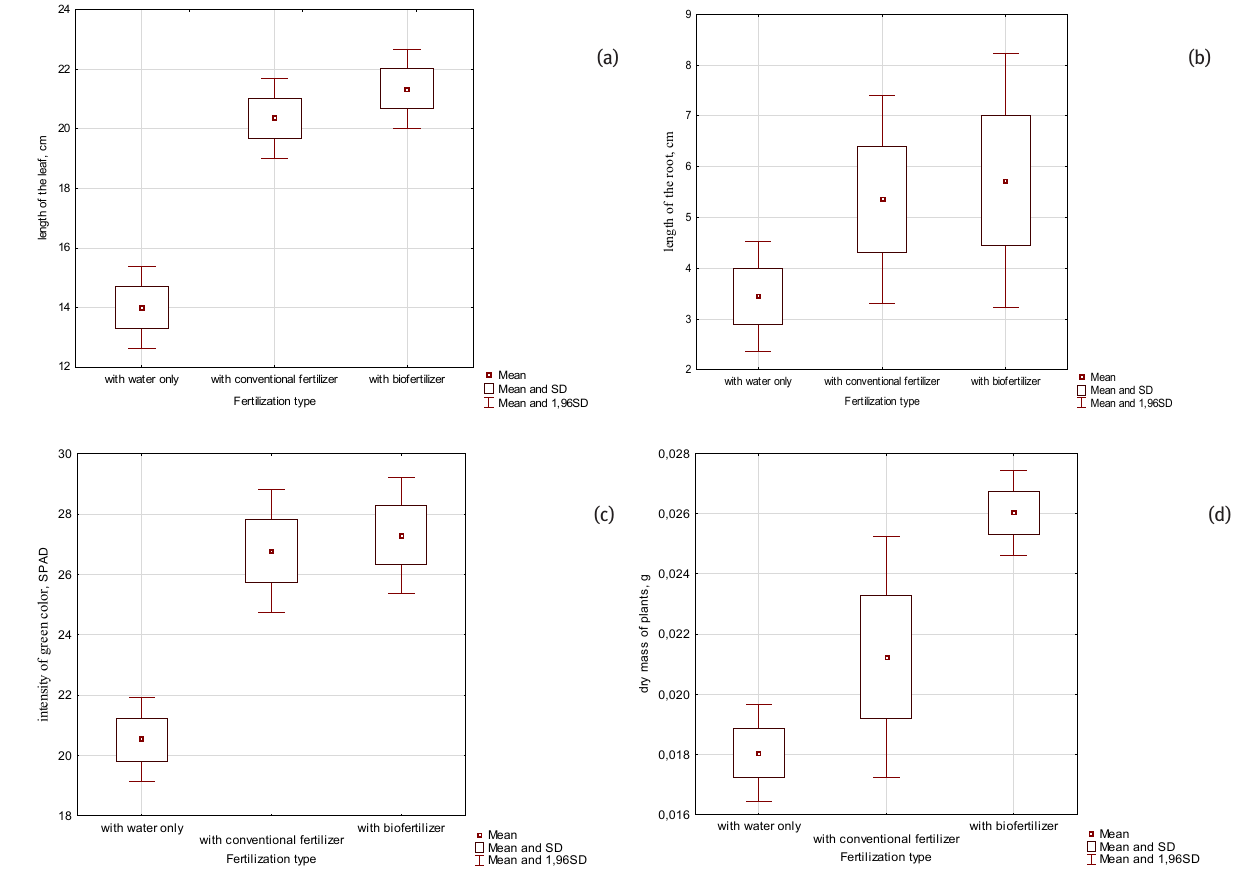
Figure 2: The growth parameters of plants in hydroponic test; a – length of the leaf, b – length of the root, c – intensity of green color, d – the dry mass of plants Table 2: Statistically significant differences between wheat growth parameters in hydroponic tests; LL - length of the leaf, cm, LR - length of the root, cm, G - intensity of green color, SPAD, MP – the dry mass of plants, g